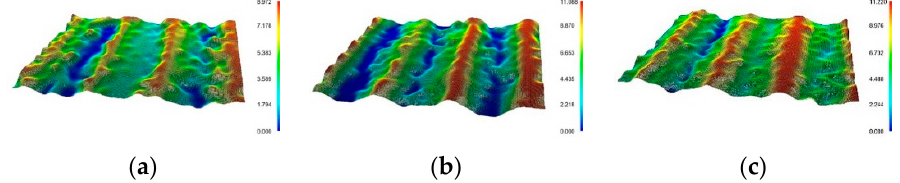
Figure 3. The effect of the static load in UNSM treatment on the surface topography of Alloy 600 by 3D microscope (×600): ( a ) 10 N; ( b ) 30 N; ( c ) 50 N.